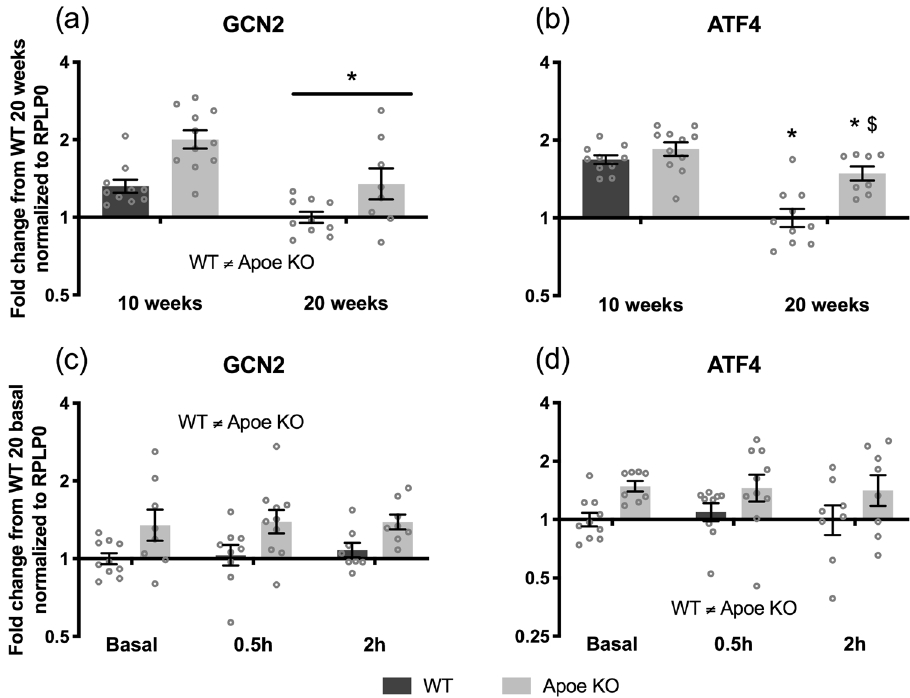
Figure 5. Amino acid deprivation response pathway. mRNA expression of GCN2 (A + C), ATF4 (B + D), in WT (dark bars) and Apoe KO (grey bars) at 10 weeks (WT n = 10, Apoe KO n = 11) and 20 weeks (WT n = 10, Apoe KO n = 8) basal, 0.5 h (WT n = 9, Apoe KO n = 9), and 2 h (WT n = 8, Apoe KO n = 8) after whey- protein ingestion. Data were normalized to RPLP0 and expressed as fold change from WT 20 weeks/basal and individual values are shown with bars indicating geometric means ± back-transformed SEM. * difference between time points p < 0.05, $ different from WT mice p <